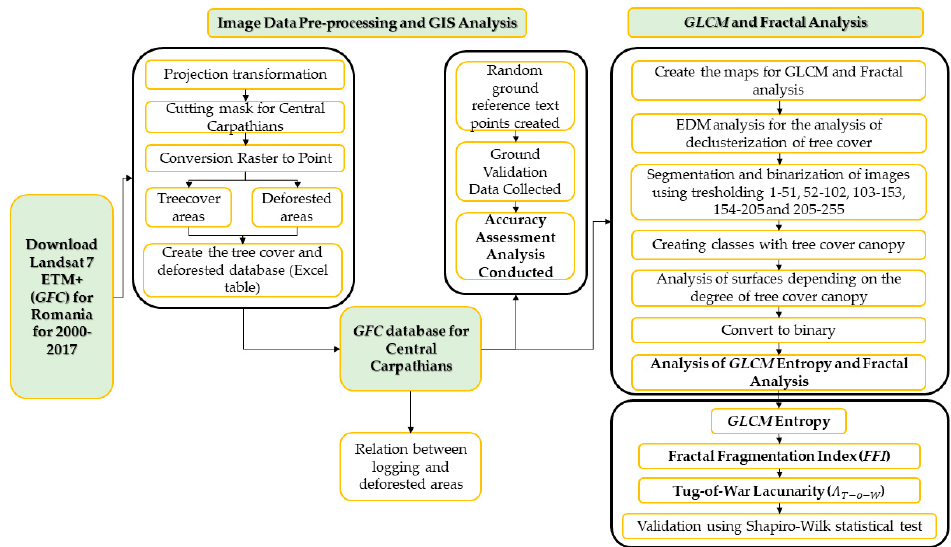
Figure 2. Flowchart of image data pre-processing and Geographic Information System Analysis (GIS analysis), accuracy assessment and Gray-Level Co-occurrence Matrix (GLCM) and fractal analysis of forest dynamics in Central Carpathians Romania.